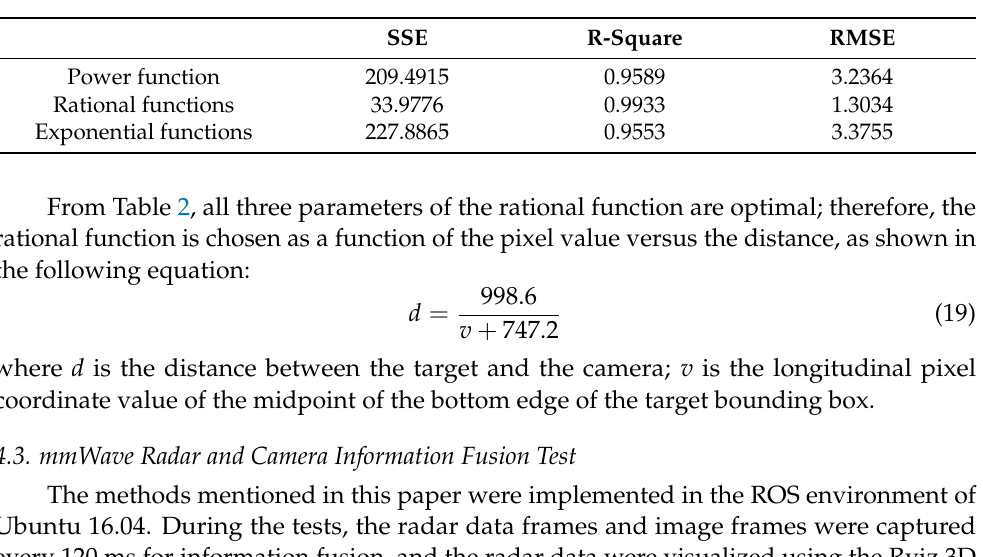
Table 2. The performance comparison of the three fitting curves.